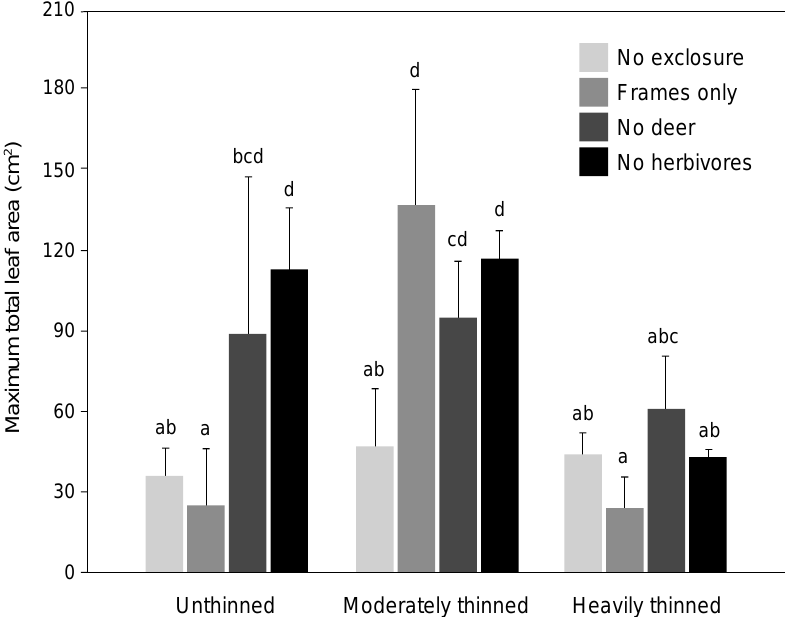
Figure 4. Mean maximum total leaf area (cm 2 ) exhibited by Platanthera integrilabia individuals emerged from tubers planted in early 2019 during the subsequent growing season as determined from monthly measurements in a forested study site in the Bridgestone–Firestone Centennial Wilderness, TN, USA. Tubers were planted, and plants were grown in main plots with unthinned, moderately thinned, and heavily thinned woody vegetation in vertebrate herbivore access subplots that included unexclosed controls (no exclosure), open exclosure frames (frames only), exclosures designed to exclude white-tailed deer only (no deer), and exclosures designed to exclude all vertebrate grazers (no herbivores). These subplots were considered as replicates in our experimental design; n = 3–4 for all means depicted. Error bars represent ± 1SE of the mean. Values shown below the same letter are not significantly di ff erent at the p ≤ 0.05 level of significance. Table 2. Results of two-way analysis of variance (ANOVA) to test for the main e ff ects and interactions of vegetation thinning and vertebrate herbivore access on the leaf-level physiology of Platanthera integrilabia individuals that emerged from tubers planted in early 2018 and 2019 in a forested study site in the Bridgestone–Firestone Centennial Wilderness, TN, USA. All variables were derived from photosynthetic light-response curves; variables include maximum rate of light-saturated photosynthesis ( A max ; µ mol CO 2 m − 2 s − 1 ), rate of dark respiration ( R d ; µ mol CO 2 m − 2 s − 1 ), apparent quantum yield (QY; µ mol CO 2 µ mol − 1 photons), and light compensation point (LCP; µ mol photons m − 2 s − 1